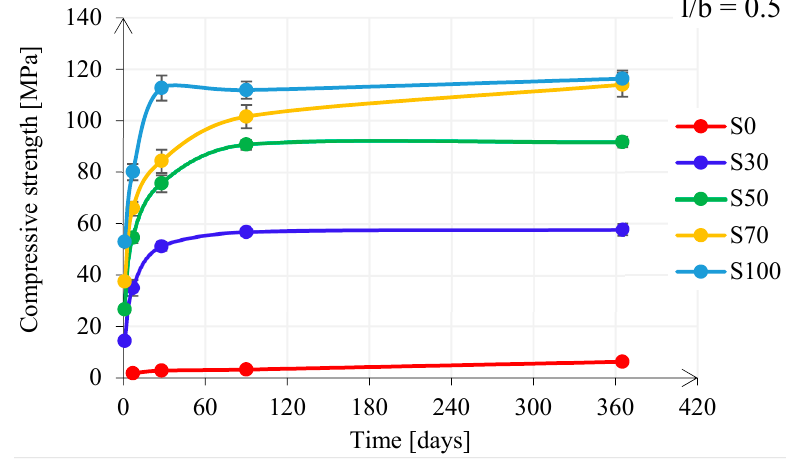
Figure 12. Compressive strength development for pastes with l/b = 0.5.